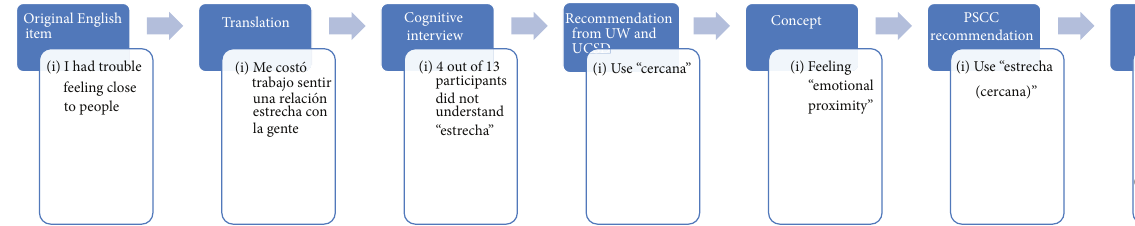
Original English item